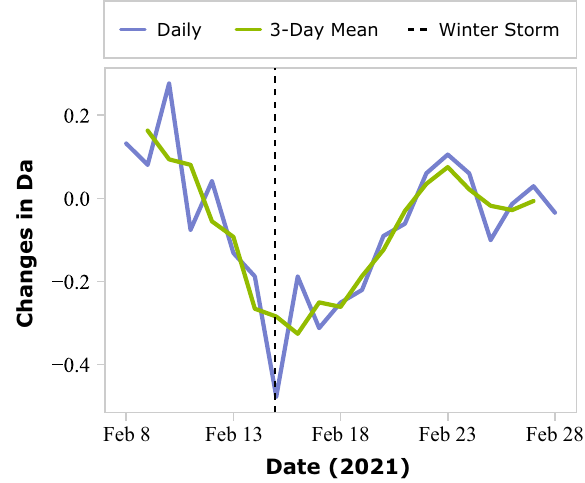
Fig. 3 Activity density (Da) changes of a census tract in Harris County compared to its baseline period during the winter storm. The census tract experienced an almost 50% decrease in population activity on February 15, 2021, when the winter storm reached, and recovered to the normal states with a few fl uctuations about February 22,